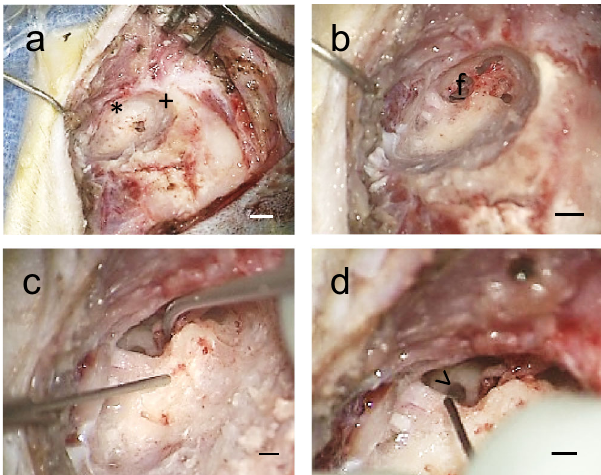
Fig. 2 Representative images of the surgical procedure in a rhesus macaque ’ s left ear. a Mastoidectomy was performed to identify the posterior wall of the external auditory canal anteriorly (asterisk) and the tegmen mastoideum superiorly (plus sign). b Extended facial recess (f) approach was used to expose the round window membrane after skeletonizing the facial nerve and cutting the chorda tympani nerve for access. c A 2-mm fenestration in the oval window was performed. d AAV vector was microinjected through the round window membrane (greater- than sign) using a pump. Scale bars, 5 mm in a/b and 1 mm in c/d. See also Supplementary Movie